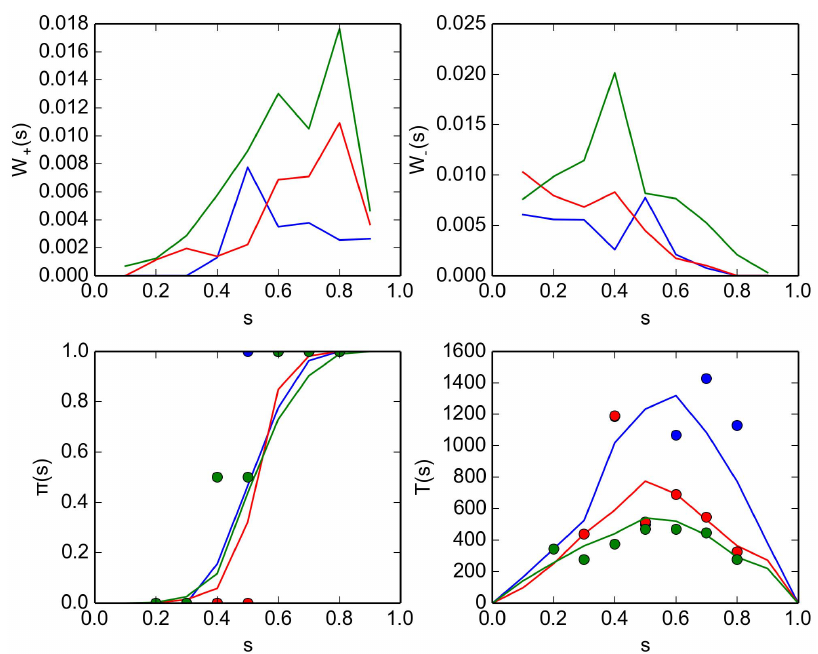
Figure 9. Comparison of properties of the kilobot swarm for different values of the avoidance radius d a . Shown are results for d a ~ 4 cm (blue curves and markers), d a ~ 6 cm (red curves and markers) and d a ~ 8 cm (green curve and markers). The experimental setup is described in Section "Kilobot experiments’’ (subsection 1). (top panels) Jump probabilities W z ( s k ) (left) and W { ( s k ) (right) for the Master equation (10) as inferred from the experiment records [Eq. (63)]. (bottom left panel) Splitting probability p ( s k ) , as estimated directly from the experimental records [cf. Eq. (53)] (markers) and computed using the solution of the Master equation Eq. (68) (curves). (bottom right panel) Decision time T ( s k ) as estimated from the experiment records [Eq. 58] (markers) and computed from the Master equation [Eq. (69)] (curves).